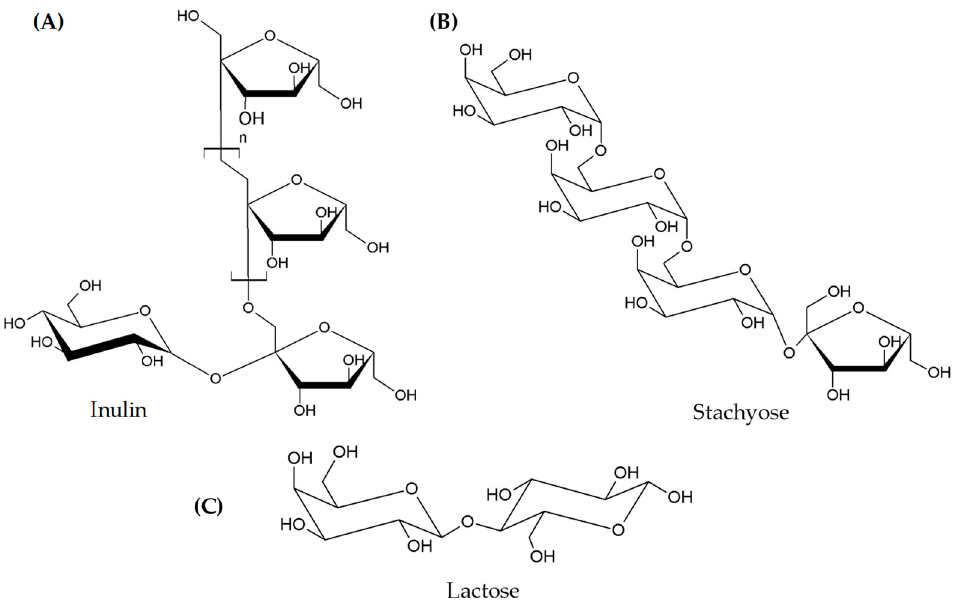
Figure 1. Examples of FODMAPs’ chemical structures. ( A ) Fructans: e.g., inulin composed by fructose units linked β (2-1) glycosidic bonds, with a total polymerization degree according to the origin plant; ( B ) Galacto-oligosaccharides: e.g., stachyose consisting of sucrose that has an α -D-